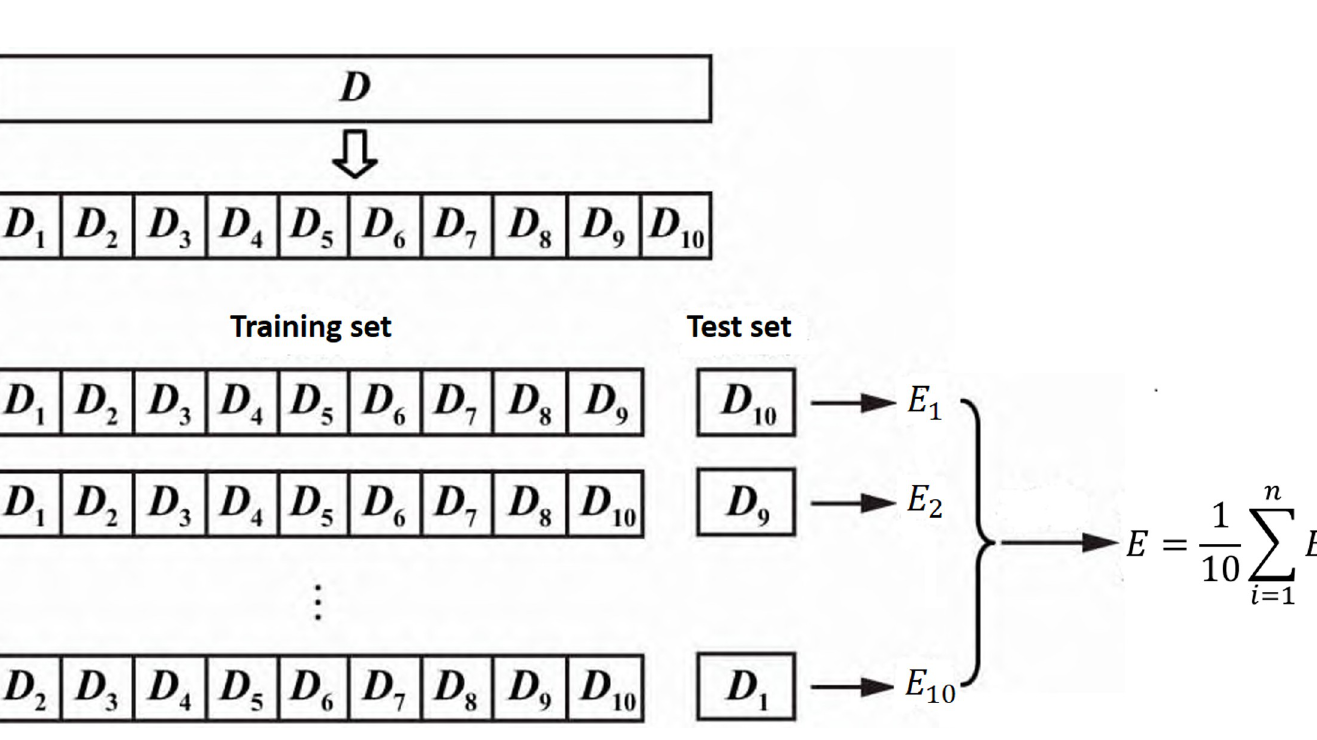
PLOS ONE | https://doi.org/10.1371/journal.pone.0282429 February 28,